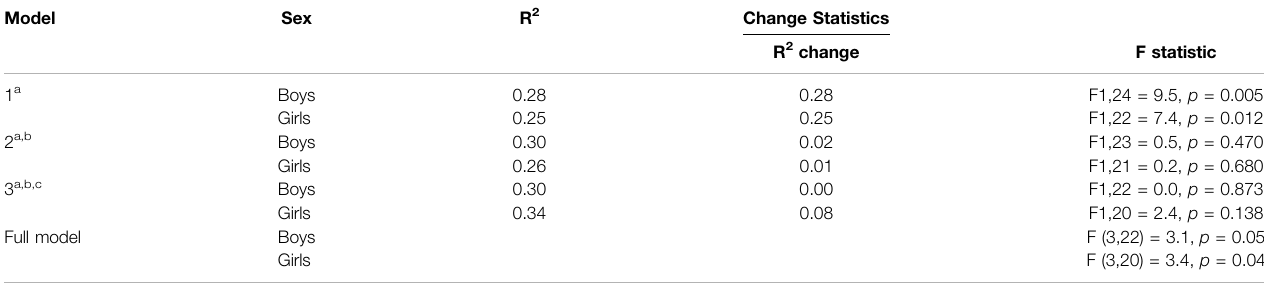
TABLE 4 | Full stepwise multiple regression analysis of V _ O 2peak (model 1), Σ O 2def (model 2), GE (model 3) for distance performance.